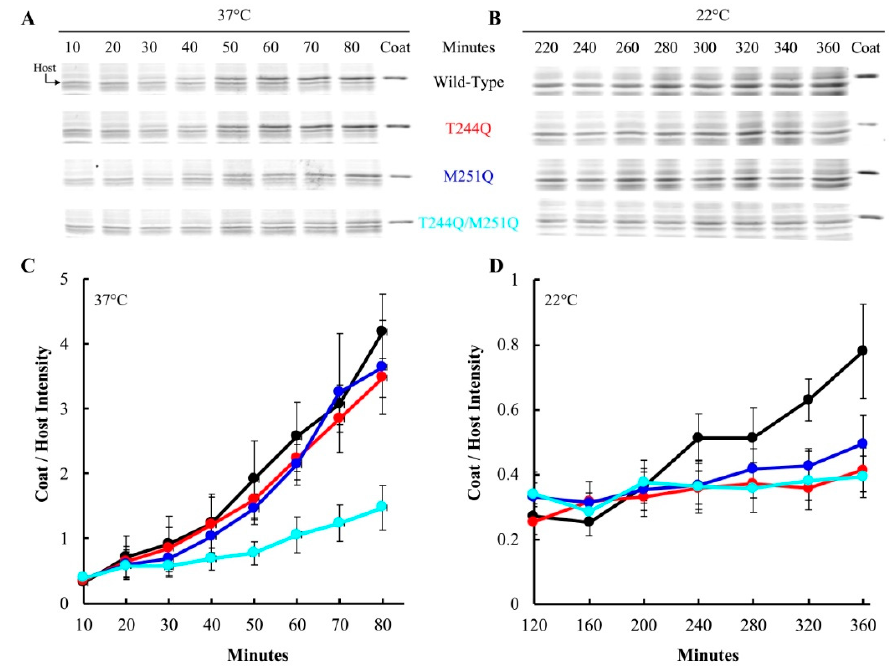
Figure 3. Viral coat protein levels in infected cells as a function of the infecting particles’ H protein. The infecting virions were generated in am(H)M251 infected cells expressing different H gene clones. These particles were then used to infect lysis resistant cells expressing a clone of the wild-type H gene. ( A , B ) Representative SDS-PAGE analysis of infected cells incubated at 37 and 22 ◦ C, respectively. ( C , D ) Coat to host protein ratios of infected cells seen in panels ( A , B ). The host protein band used in this analysis is indicated with an arrow in panel ( A ). A color legend indicating the H protein carried in the infecting virion is between panels ( A , B ). Error bars represent the standard error of the mean calculated from three biological replicates.